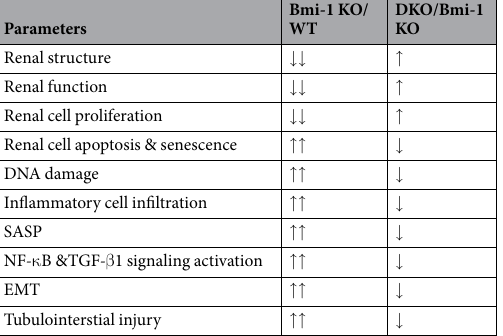
Table 1. P16 INK4a deletion largely rescued renal aging phenotypes caused by Bmi - 1 deficiency. ↓ : presents reduction or inhibition; ↑ : presents increase or